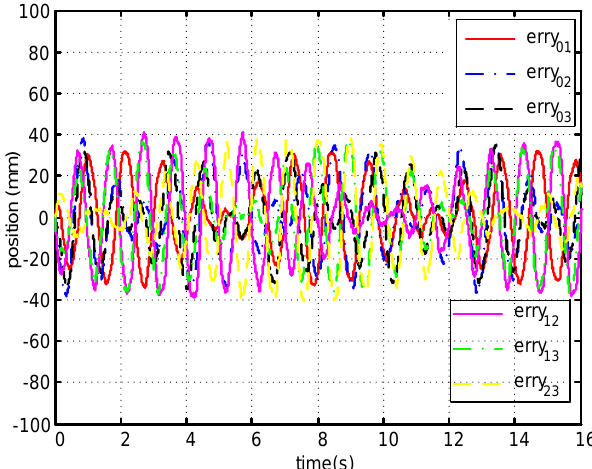
Figure 10. Dynamic position response waveforms of relative signals under independent tracking control